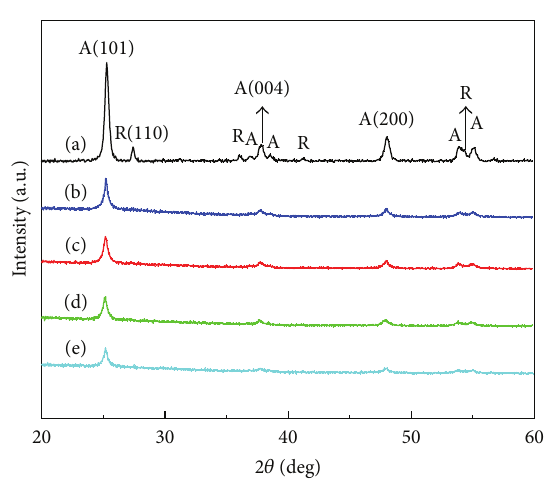
Figure 1: XRD patterns of P25 (a), C/TiO 2 (b), and Pt-C/TiO 2 composites (c)–(e). The content of Pt is 0.1 wt% (c), 0.4 wt% (d), and 0.6 wt% (e), respectively. (A: anatase, R: